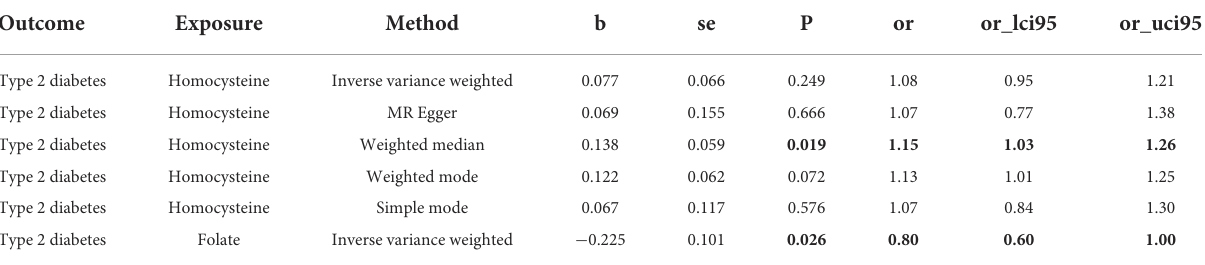
TABLE 3 Summary Mendelian randomization estimates of circulating homocysteine and folate levels on risk of type 2 diabetes. Outcome